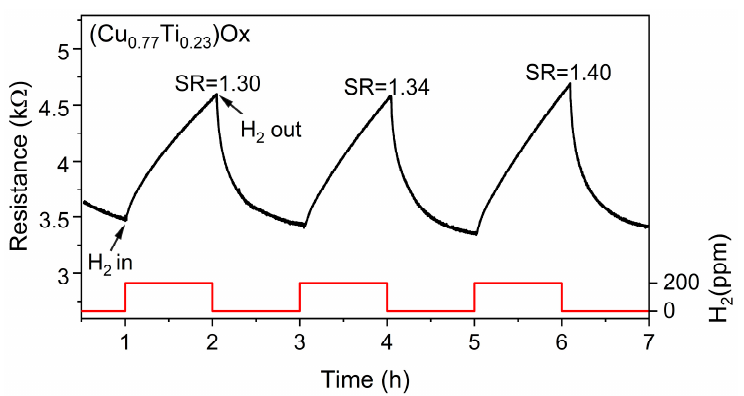
Figure 5. Three cycles of changes in electrical resistance of (Cu 0.77 Ti 0.23 )Ox thin film annealed at 473K upon exposure to 200 ppm of H 2 .